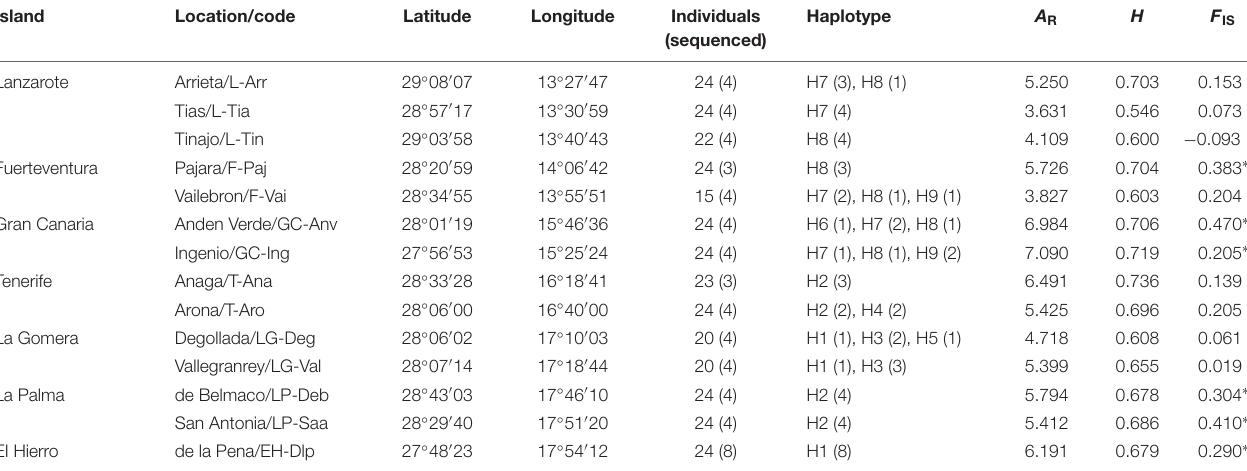
TABLE 1 | Location, sample size, and gene diversity of the sampled populations of Kleinia neriifolia on the Canary Islands. Island Location/code Latitude Longitude Individuals